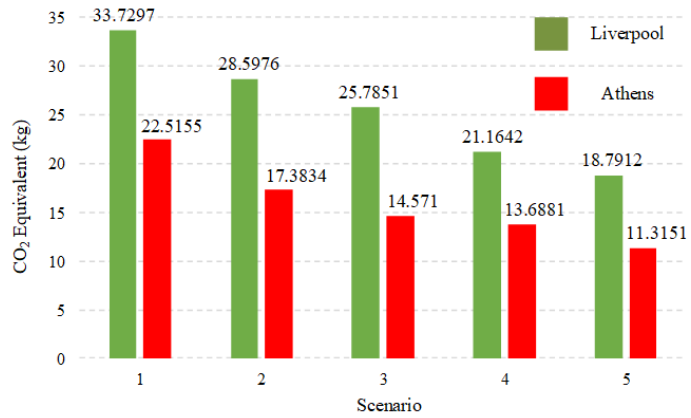
Figure 6. The CO 2 equivalent production of the Biochrom 30+ amino acid analyzer physiological system with the HVAC system power ratings for Liverpool and Athens in October.